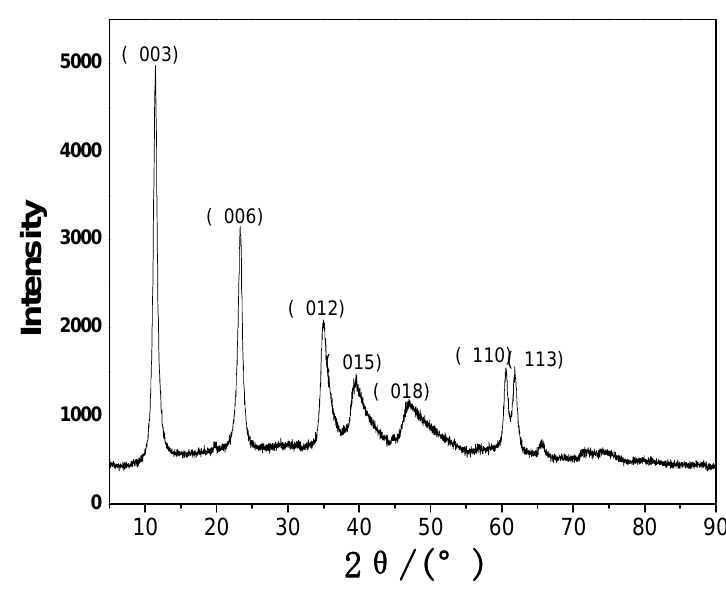
Figure 1. XRD patterns of Ni/Al HTlcs.